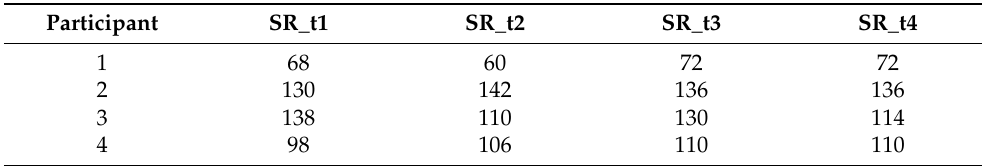
Table 16. Speaking rate (words per minute) individual and mean measurements at four assessment time